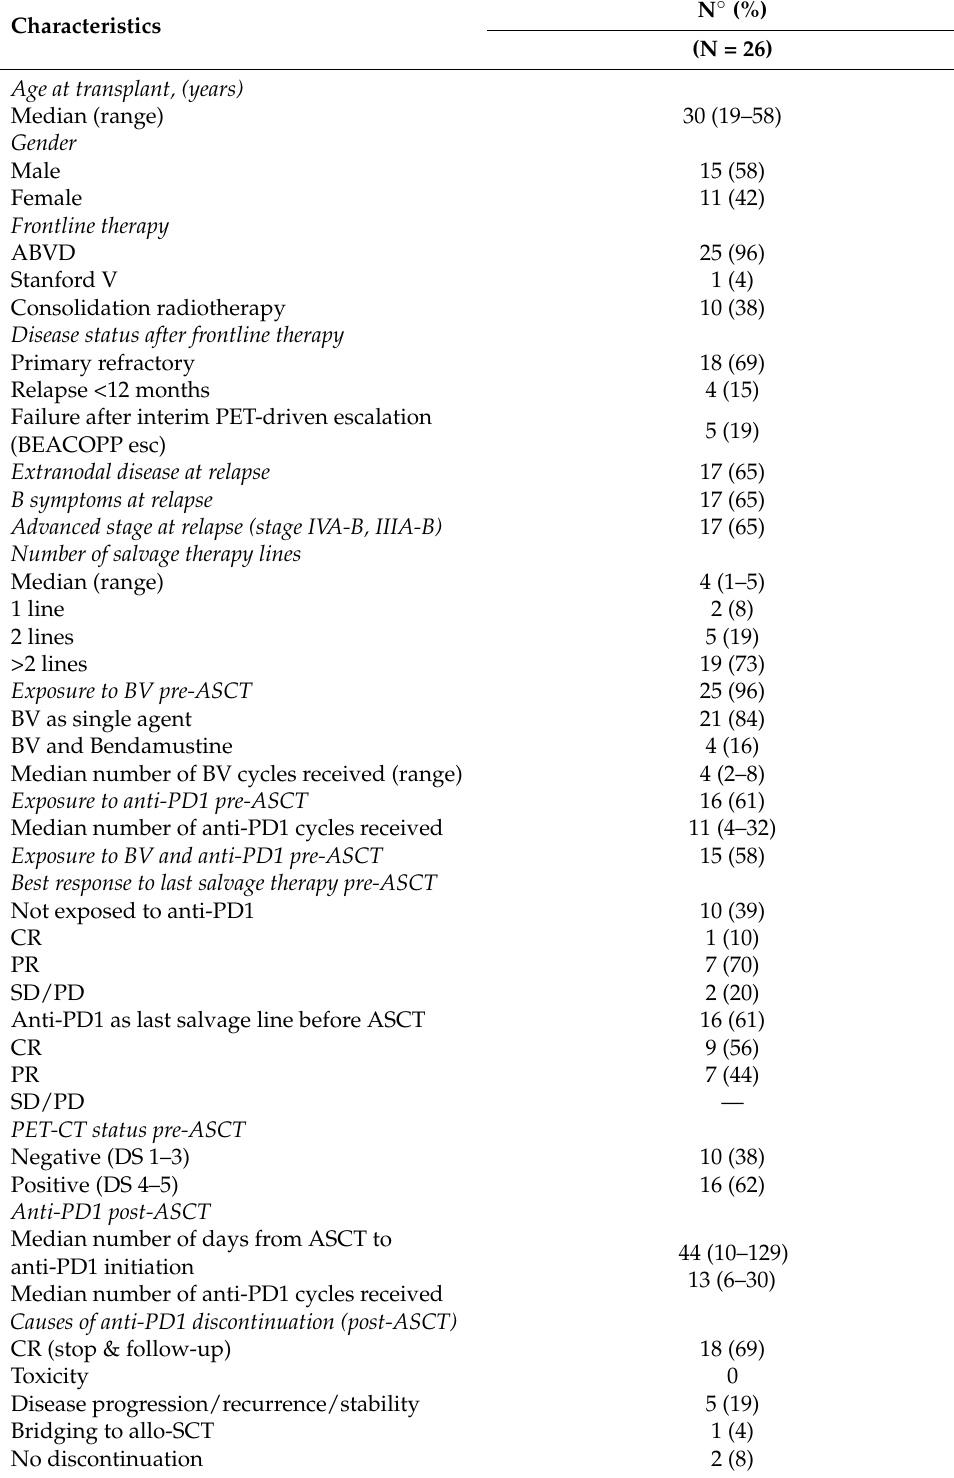
Table 1. Summary of demographic and clinical characteristics of 26 patients with high-risk RR-HL who received post-ASCT consolidation with